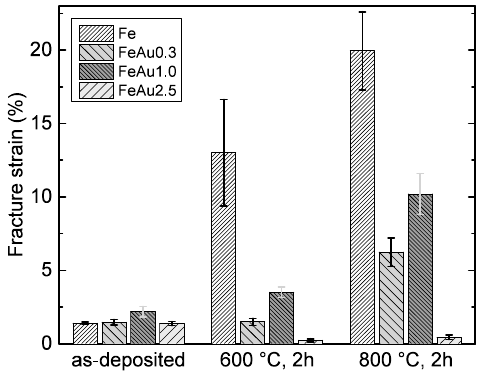
Figure 2. Fracture strain of the Fe, FeAu0.3, FeAu1.0 and FeAu2.5 samples, before and after different heat treatments.